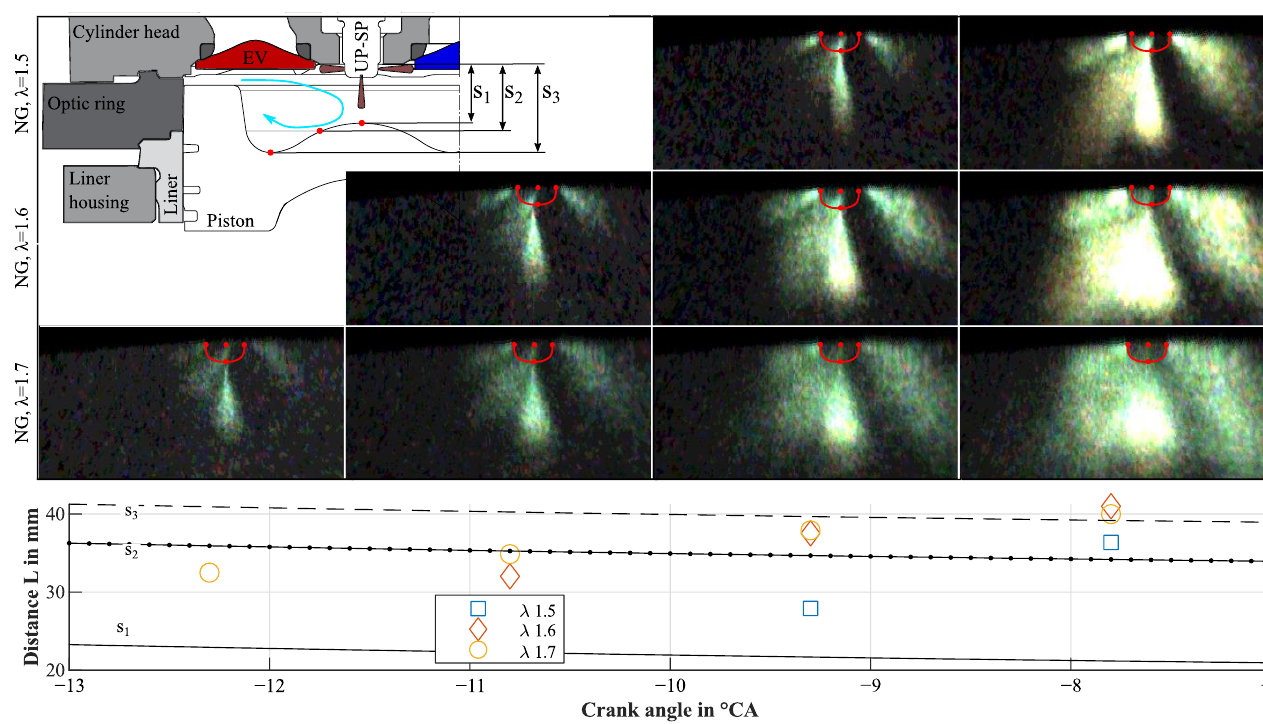
Figure 19. Torch ray images for NG at CoC = 8 °CA AFTDC and λ=1.5, 1.6, 1.7. Distances s measured from the flame deck to the piston bowl.